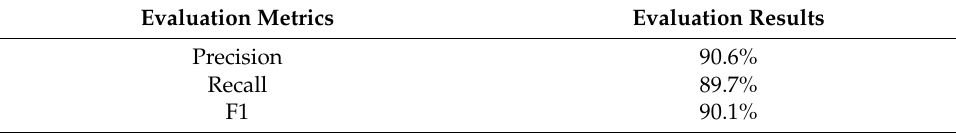
Table 9. Results of FP trigger extraction.